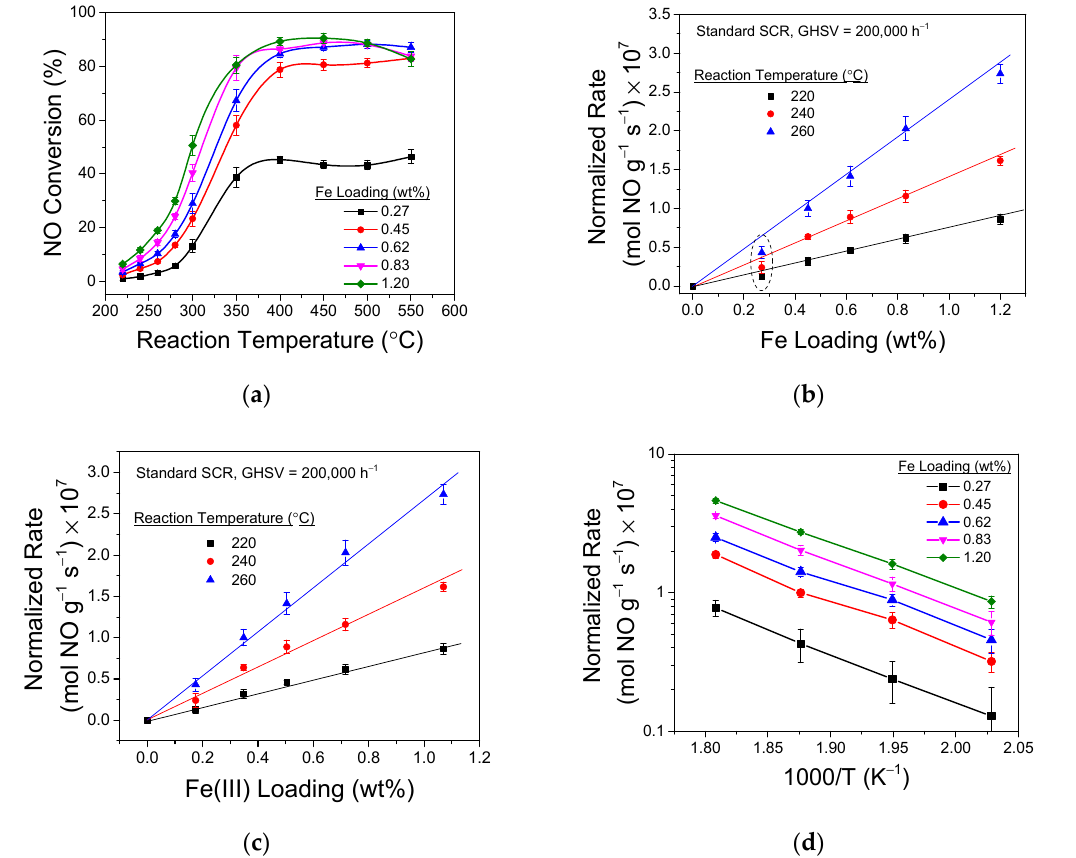
Figure 16. Conversion-temperature curves for standard NH 3 -SCR on Fe / SSZ-13 catalysts. Only NO conversions are shown. Reactant feed contains 350 ppm NO, 350 ppm NH 3 , 14% O 2 , 2.5% H 2 O balanced with N 2 at a GHSV of 200,000 h − 1 . ( b ) Normalized SCR rates (mol NO g − 1 s − 1 ) within the di ff erential regime shown in ( a ) plotted as a function of the Fe loading at 220, 240 and 260 ◦ C. Note highlighted SCR rates on the Fe 0.27% sample that are abnormally low. ( c ) Normalized SCR rates (mol NO g − 1 s − 1 ) within the di ff erential regime shown in ( a ) plotted as a function of the Fe(III) loading at 220, 240 and 260 ◦ C. ( d ) Arrhenius plots for standard SCR in the low-temperature regime ( ≤ 280 ◦ C) indicating similar apparent activation energies for di ff erent samples. Reprinted with permission from [28]. Copyright © 2016 American Chemical